Question: Provide a one-line summary of what is displayed.
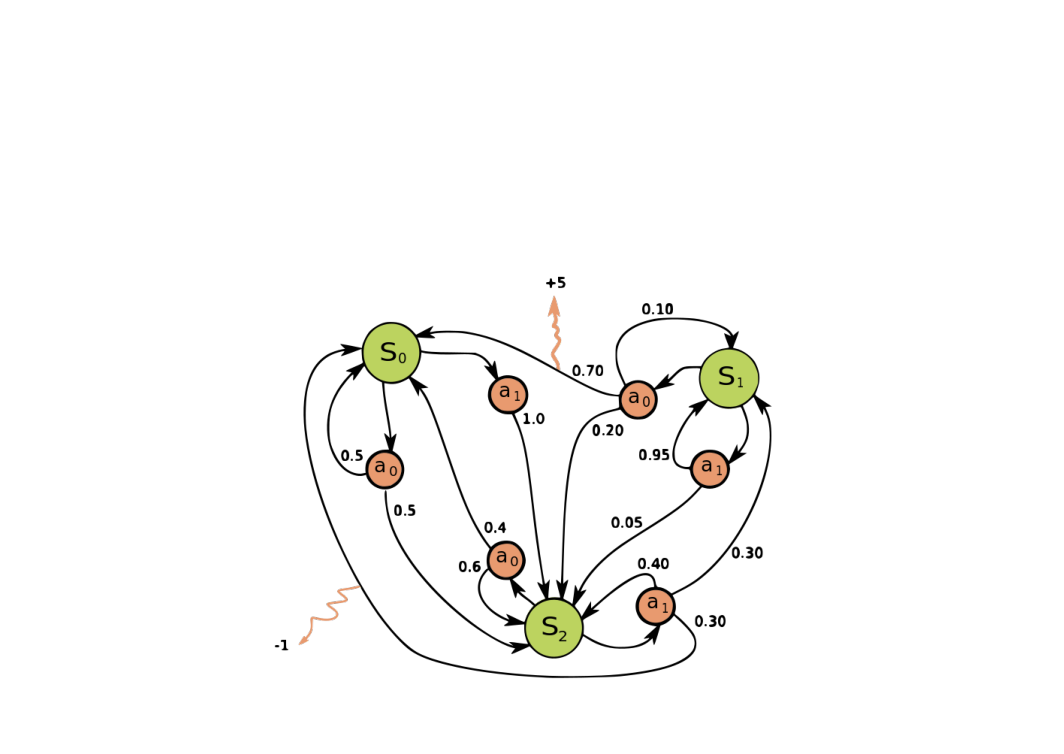
Answer: 1: Markov decision process example. Source: Wikipedia (2022, September 29) [13]